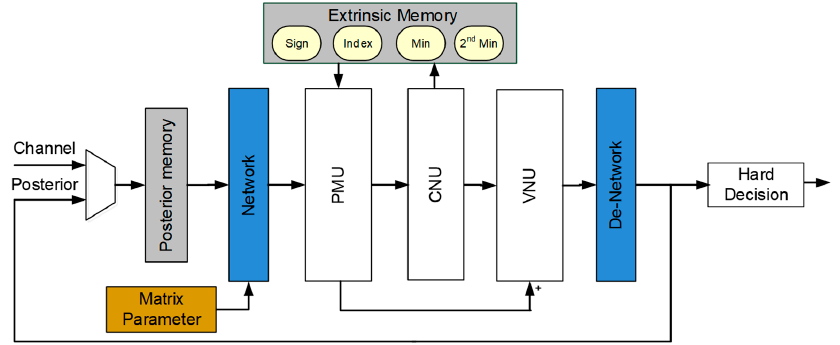
Figure 18. Reconfigurable multi-standard decoder architecture.